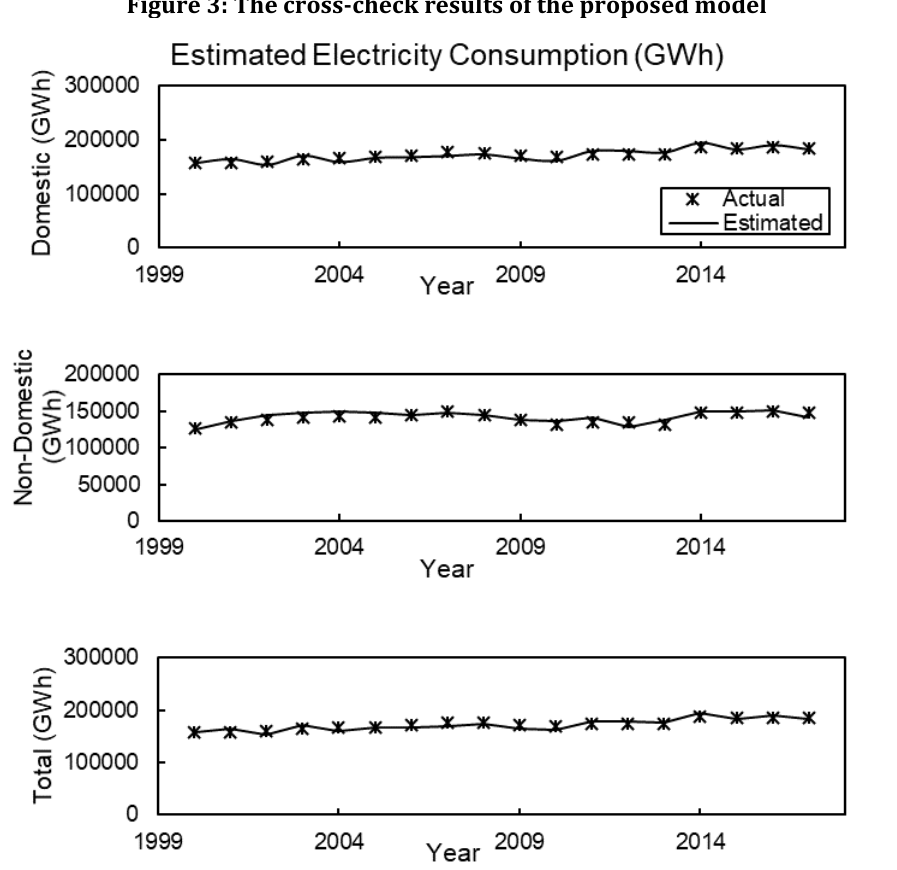
Figure 3: The cross-check results of the proposed model